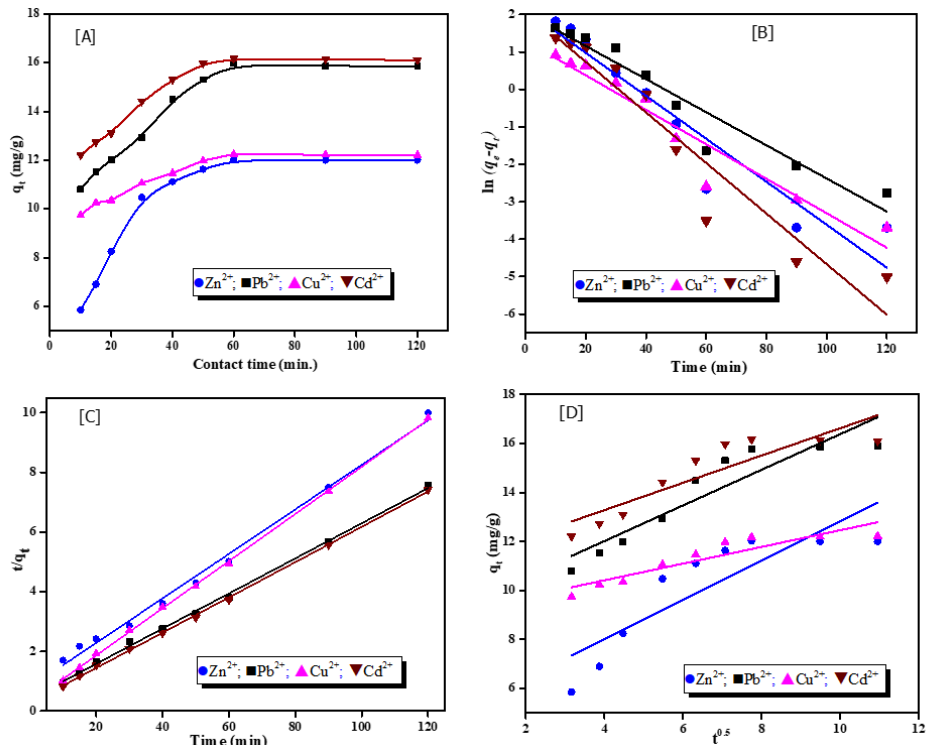
Figure 7. Effect of contact time on Zn 2+ , Pb 2+ , Cu 2+ and Cd 2+ adsorption capacity ( A ); Pseudo-first- order ( B ); Pseudo-second-order ( C ); and Intra-particle diffusion ( D ). (Adsorbent dosage = 4 gL −1 , temperature = 20 °C , initial concentration of metal ions = 50 mgL −1 and reaction time = 10–120 min.).